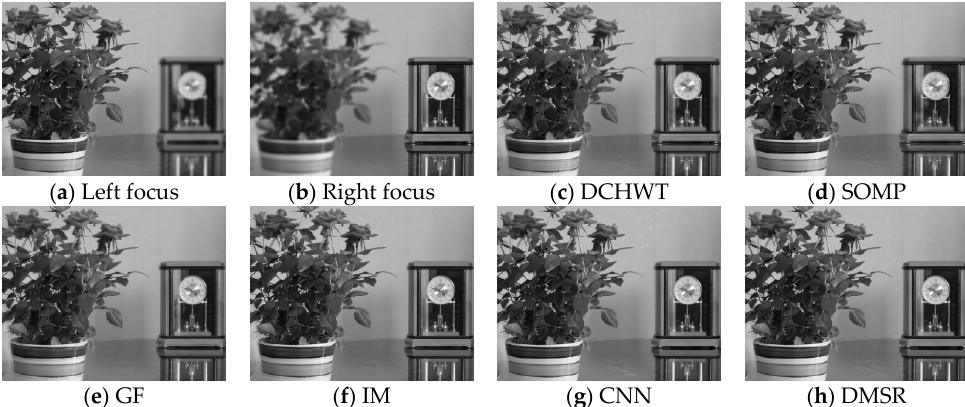
Figure 9. Normalized difference images between each of the fused images and Figure 8b. Another example, the fusion results of the “Flowerpot” image pair (944 × 736) are shown in Figure 10c–h. The normalized difference images between the correctly focused source image and the fusion results are shown in Figure 11. Similar to the previous example, the DCHWT and SOMP method produced serious artifacts around the “horologe”. The fused image obtained by the GF method suffered from a ringing effect, and the edges of the “horologe” were blurred. The results of the IM method also showed similar artifacts near the “horologe”. Although the CNN method image. Comparatively, the DMSR method exhibited the best visual quality.